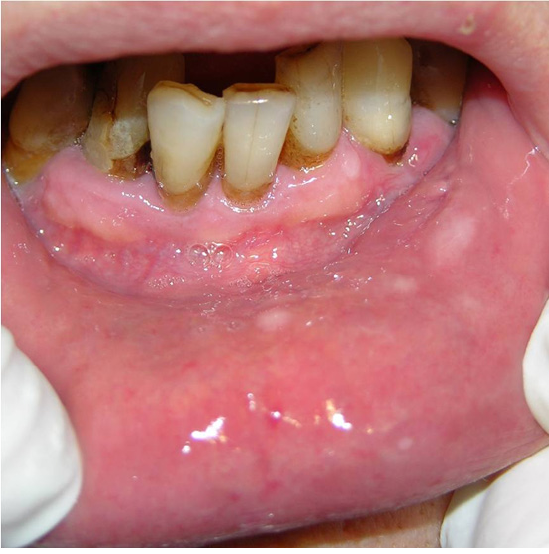
Figure 4: Surgical result at post-operative